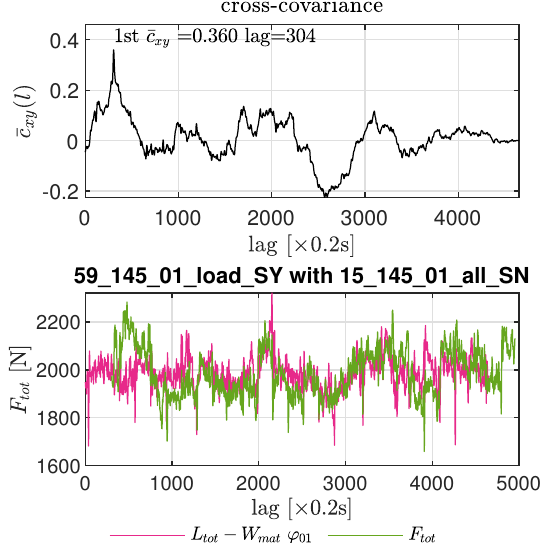
Figure 19: Second example: Cross-correlation of measured force on roller with and without material being conveyed. In the bottom plot signal overlaid with shifted signal by 1st peak’s